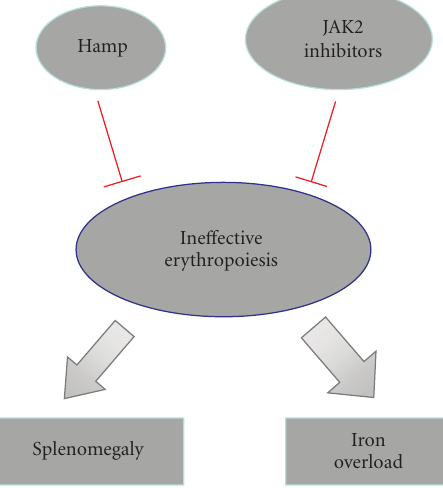
Figure 2: Di ff erent approaches to target IE in β -thalassemia. The administration of hepcidin would allow to decrease the iron over- load in organs such the liver and heart and to redistribute the iron to hematopoietic organs, allowing a more e ffi cient erythropoiesis and therefore a decrease in splenomegaly. The administration of Jak2 inhibitors would induce a decrease in the ine ffi cient erythropoietic rate, therefore decreasing spleen size. The reduced erythropoiesis would have as indirect e ff ect the increase in serum hepcidin, that in turn would decrease the iron absorption from the gut and the amelioration of iron